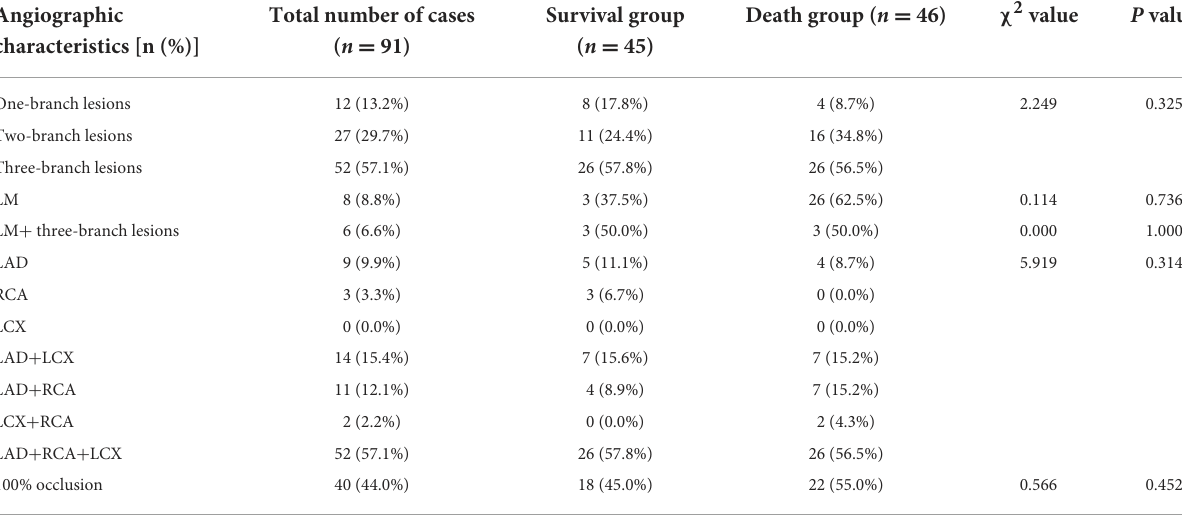
TABLE 2 Angiographic characteristics of VSR patients stratified by different prognosis. Angiographic